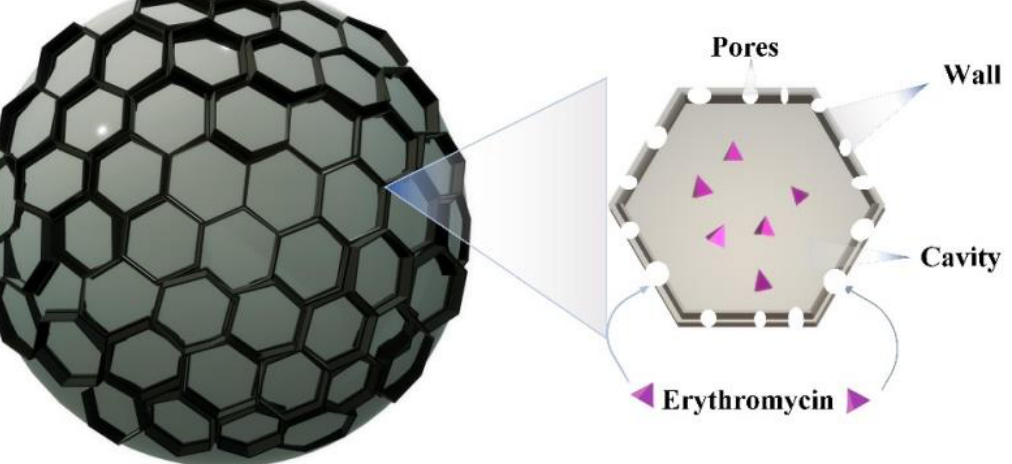
Figure 12. Schematic representation of ERY loading into sporopollenin microcapsules. Adaptation from [101].